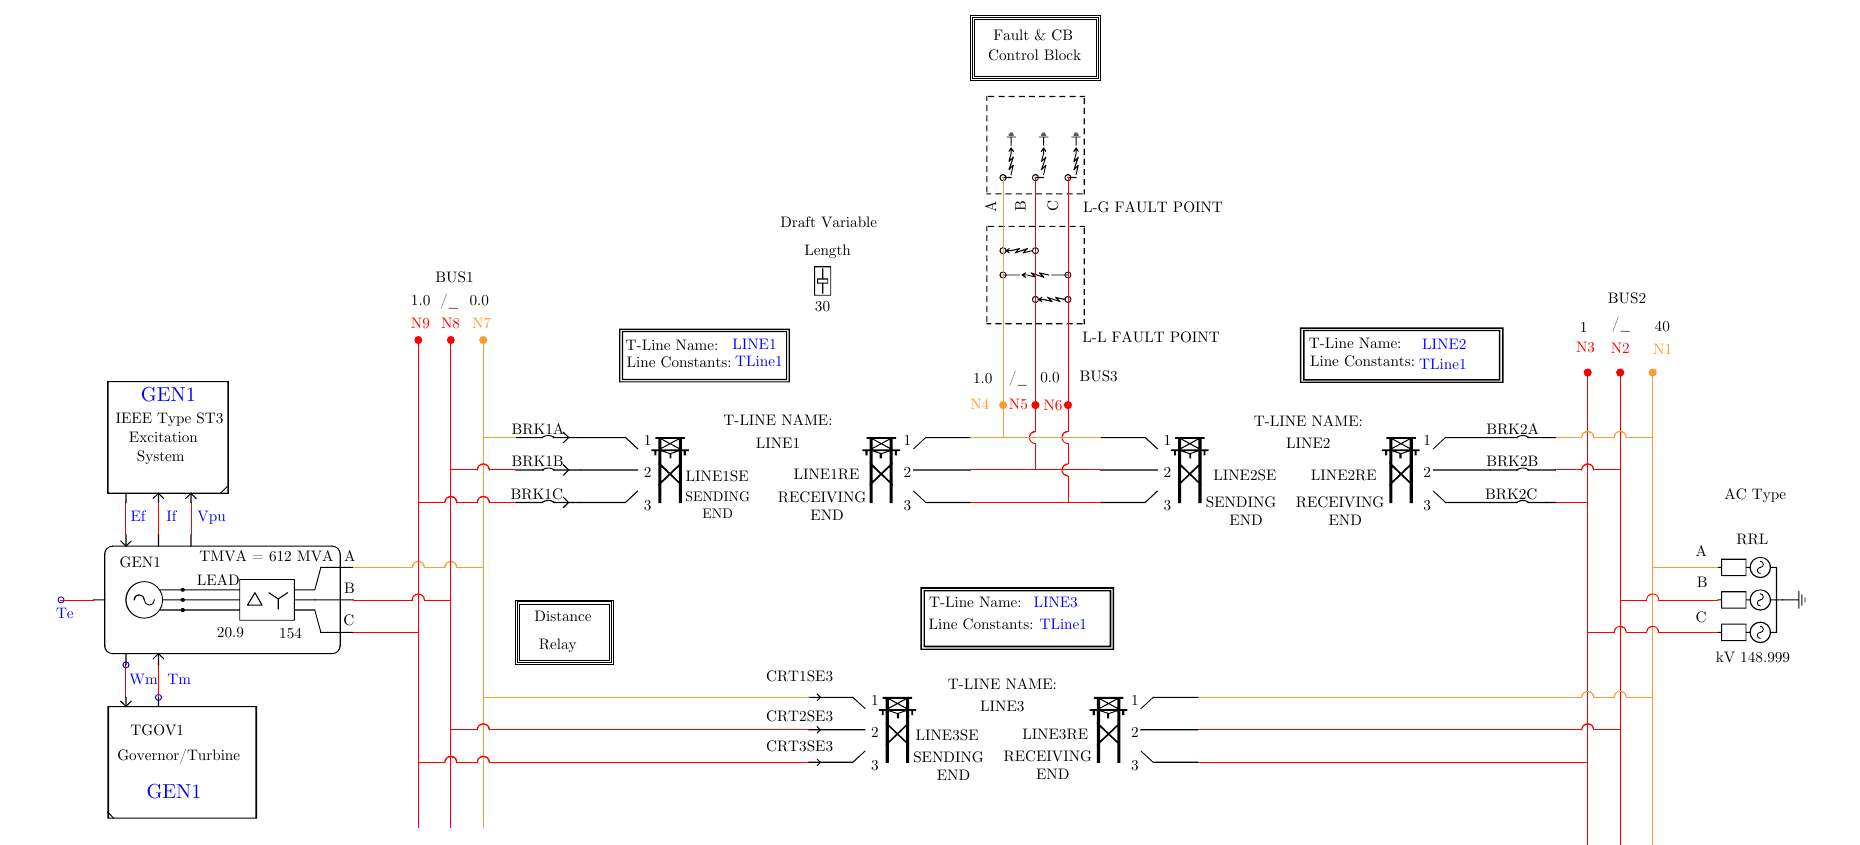
Figure 6. Single machine infinite bus system RSCAD draft